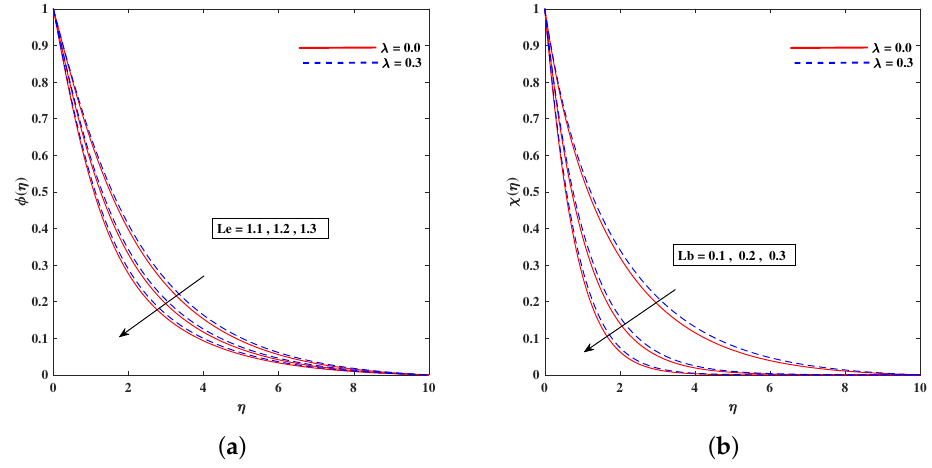
Figure 12. Fluctuation of ( a ) Le on concentration φ ( η ) and ( b ) Lb on bioconvection profile χ ( η ) .